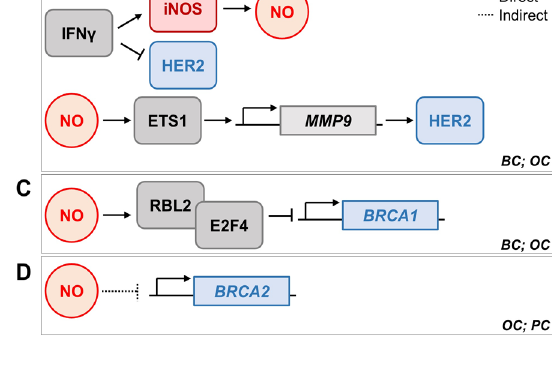
Legend Black arrows: activating Black arrows ending with a bar (————/): Inhibiting Green upward arrows: Upregulation Red down arrows: Downregulation Figure 2. Role of NO in breast cancer (BC) and other relevant cancers. ( A ) Pathways regulated by NO in BC and relative intracellular NO-mediated effects. ( B ) Direct (plain lines) and indirect (dotted lines) pathways correlating NO with HER2 (top), ( C ) BRCA1 (middle), and ( D ) BRCA2 (bottom).